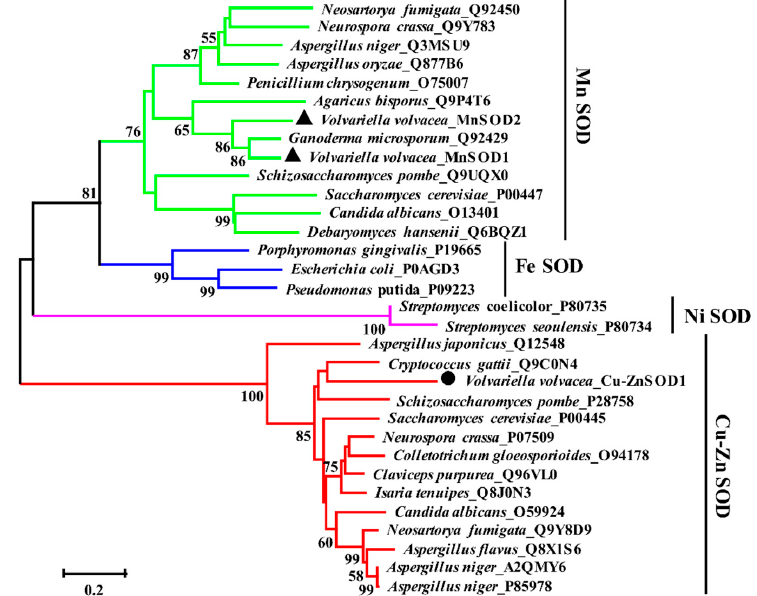
Figure 2. Neighbor-joining phylogenetic tree of SOD amino acid sequences across multiple